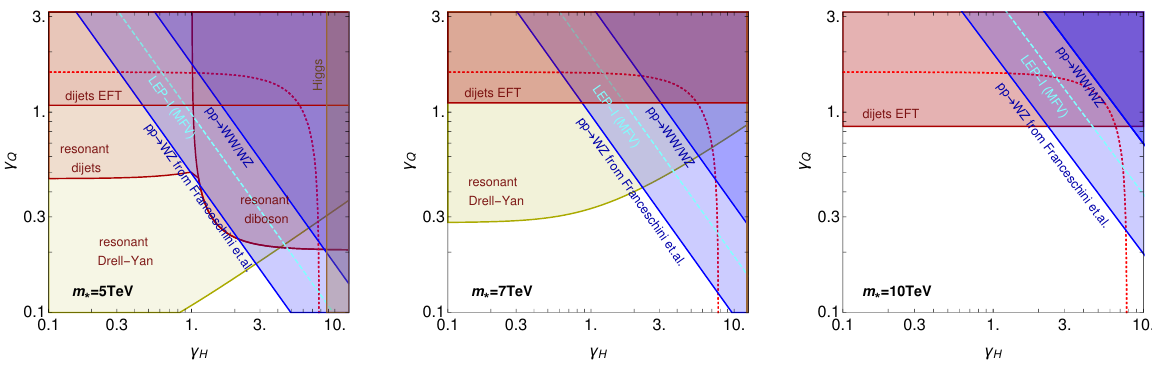
Figure 9 . 95% CL exclusion regions in the ( (cid:13) H ; (cid:13) Q ) plane for various values of the resonance masses. In blue, the projected constraints from diboson data at HL-LHC, using our projections (dark shade) or the re(cid:12)ned analysis strategy of ref. [12]. The other constraints come from a recast of the studies in refs. [21, 60{63] and are commented in detail in the